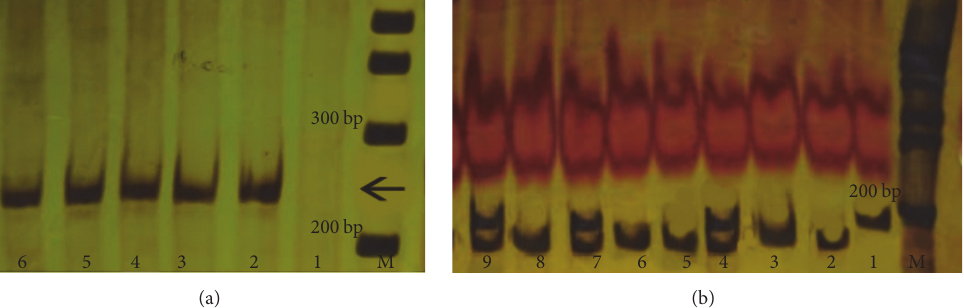
Figure 2: (a) PCR product of TNF gene corresponding to a 234 bp band; M: 100 bp DNA ladder, lane 1: negative control, lanes 2, 3, 4, 5, and 6: samples. (b) Digestion of of PCR product by NcoI, M: 100bp DNA ladder; lane 1: homozygote for the G allele; lanes 4, 7, and 9: